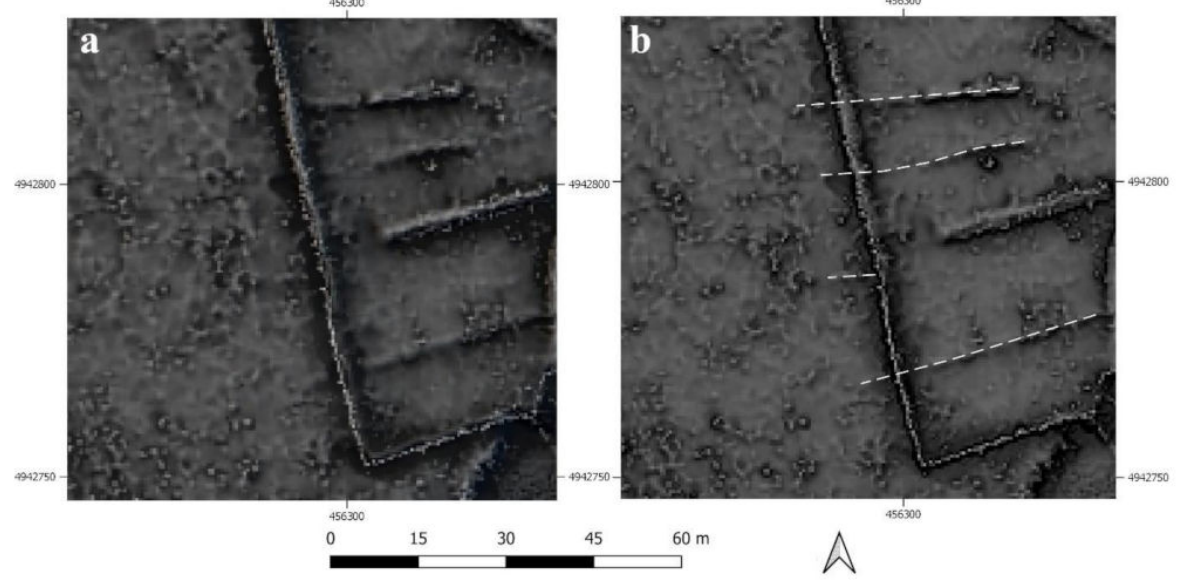
Figure 27. ( a ) Double wall that runs across the slope and borders the terraced area to the west seems to overlie some of the terrace slopes. ( b ) The pecked lines indicate terrace slopes that are overlain by the massive wall that borders the terraced area to the west (visualization: